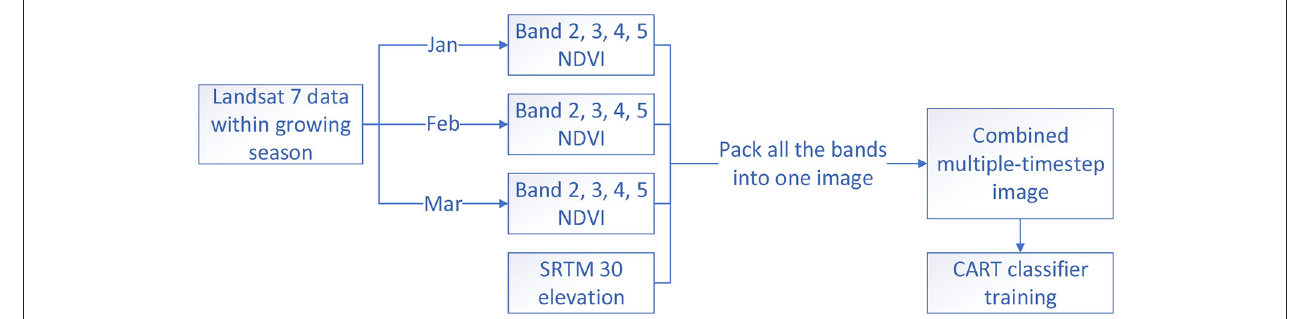
FIGURE 2 | Multiple-time step images used as predictors to train the CART classifier for cropland identification.